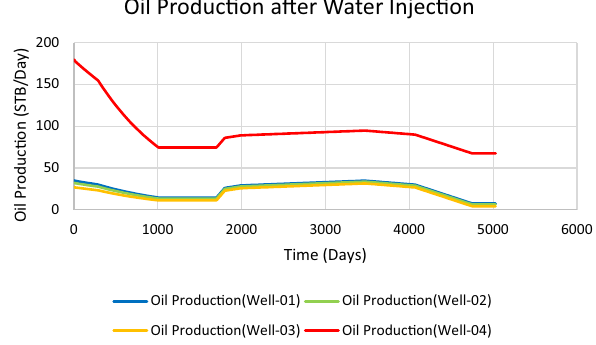
Fig. 9 Oil production after water injectivity